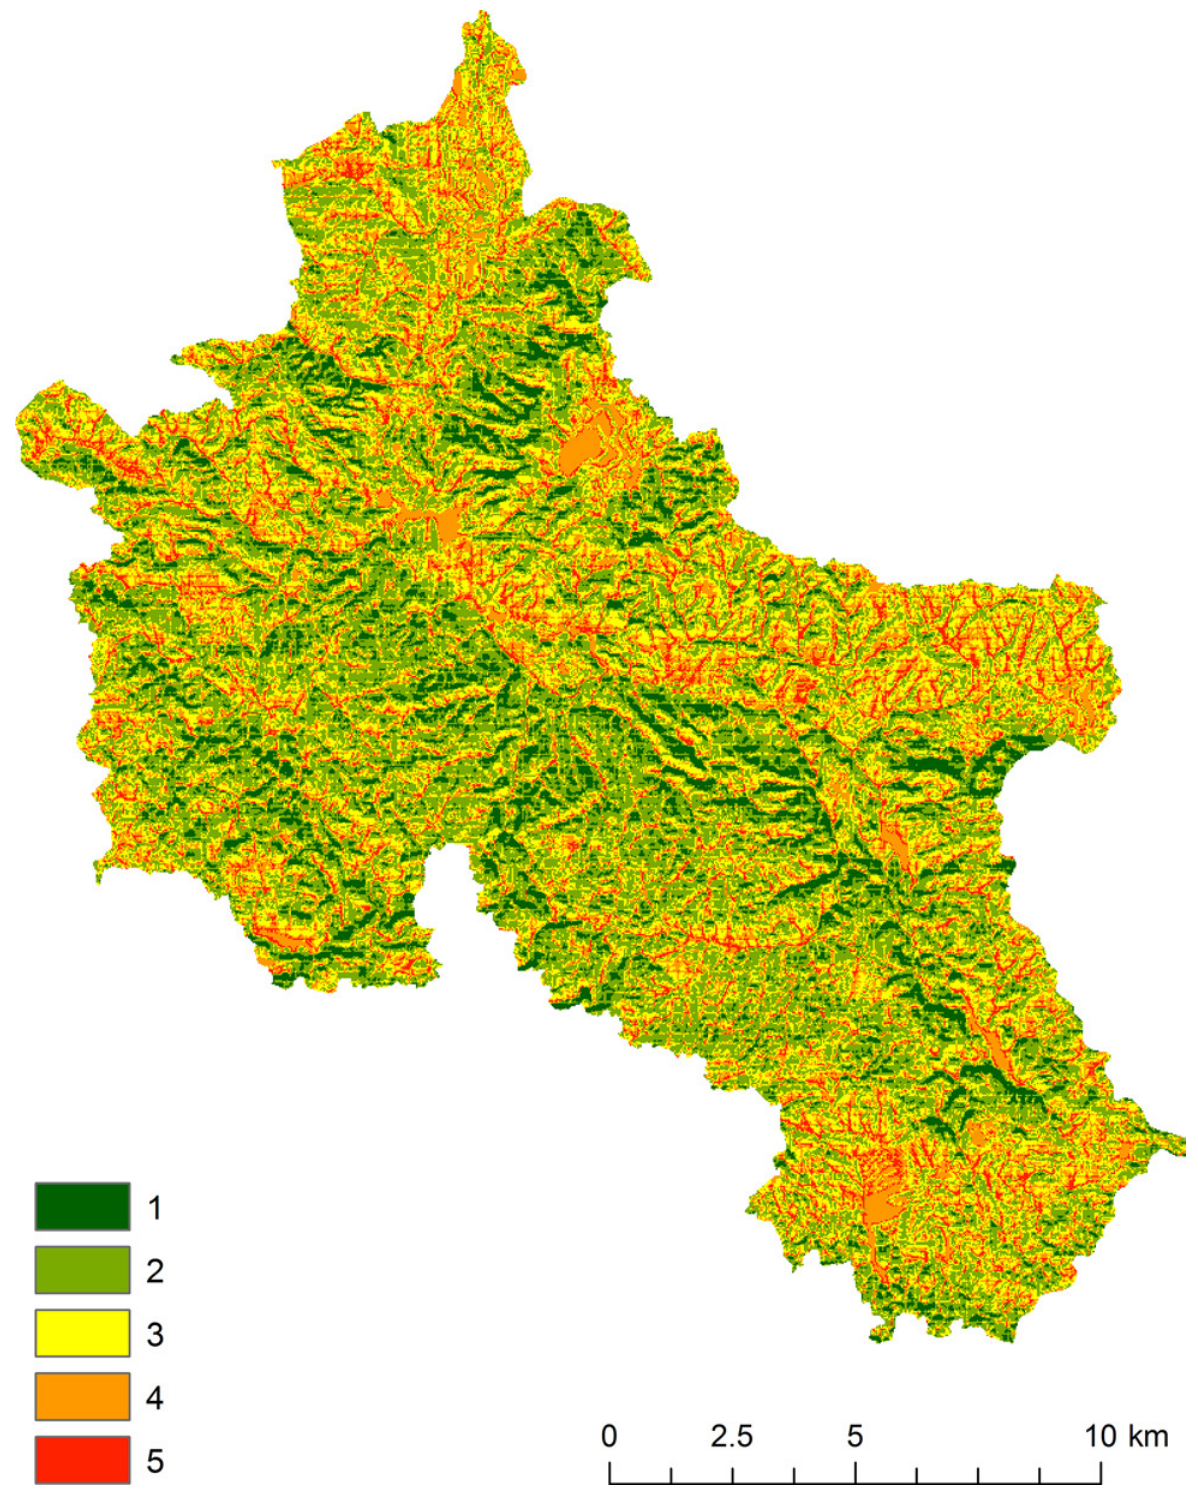
Fig. 7. Factor map of the mesoclimatic